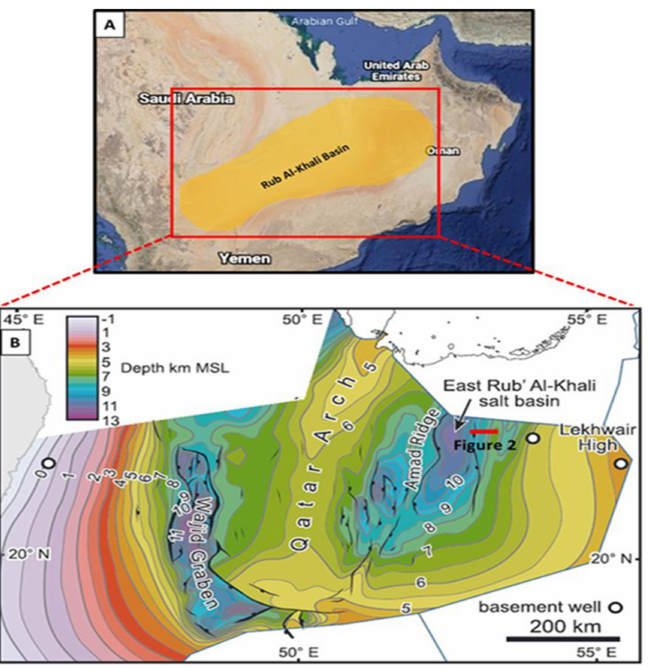
Figure 1. ( A ) Satellite image showing the location of the Rub’ Al-Khali basin. ( B ) Top basement depth structure map